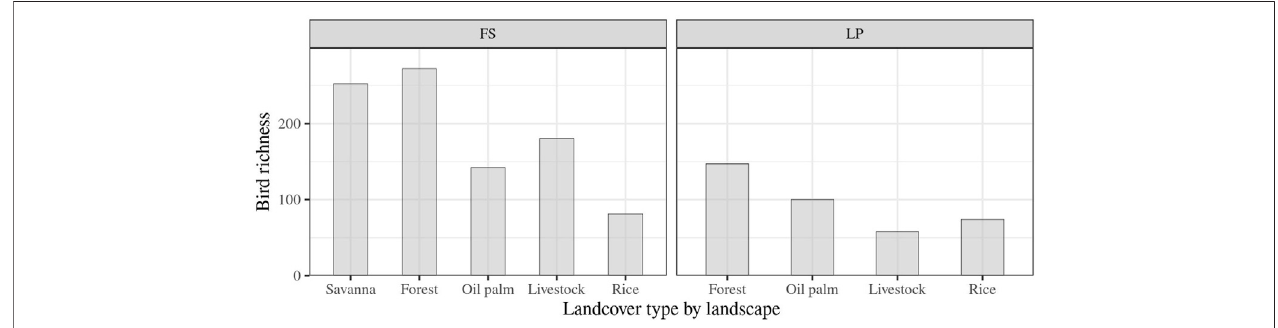
FIGURE 2 | Bird species richness collected according to the land cover type and landscape. Landscapes: LP: Llanos piedmont; FS: fl ooded